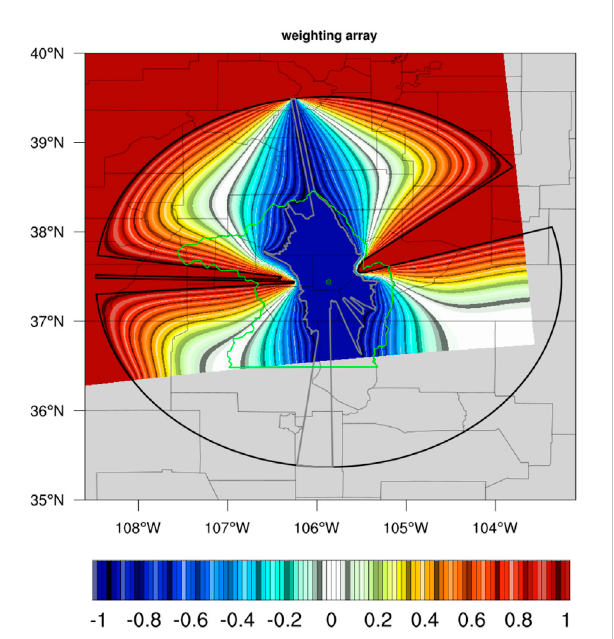
FIGURE 6 Depiction of where a radar beam intersects topography out to 230 km for various scan angles, overlaid with the difference in bias between MRMS and NLDAS. The edge of the upper Rio Grande basin is indicated with a thick gray line.